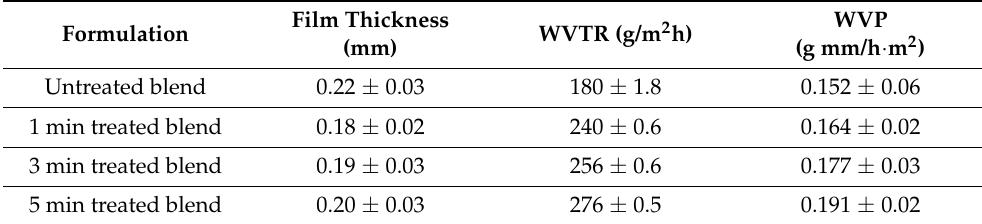
Table 2. WVTR and WVP results of different formulations.